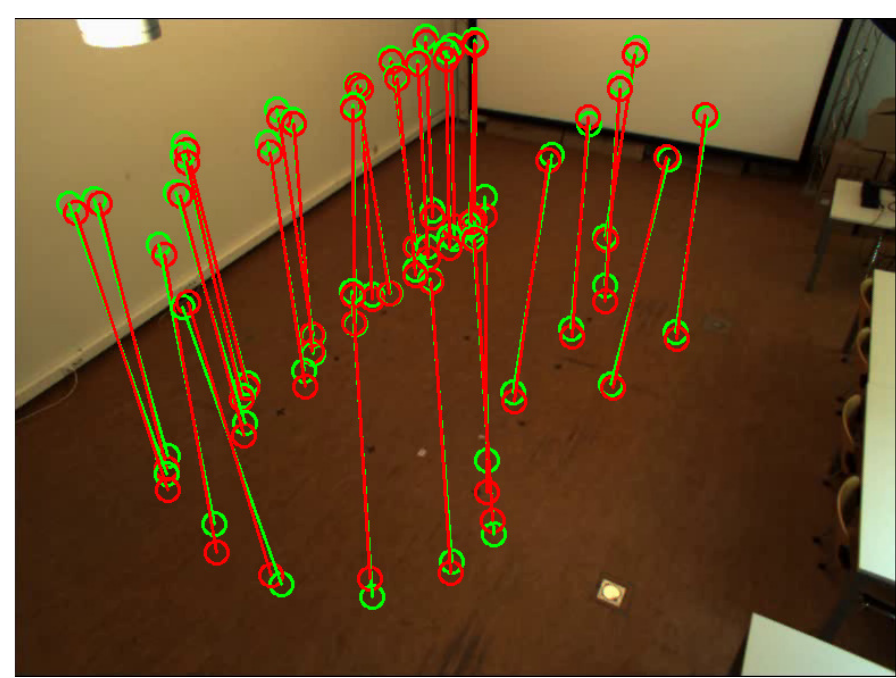
Figure 5. Distribution of the person’s positions for Camera Network 1. Green circles represent detected positions using ellipse fitting. Red circles represent detected positions using bounding box fitting and line fitting.